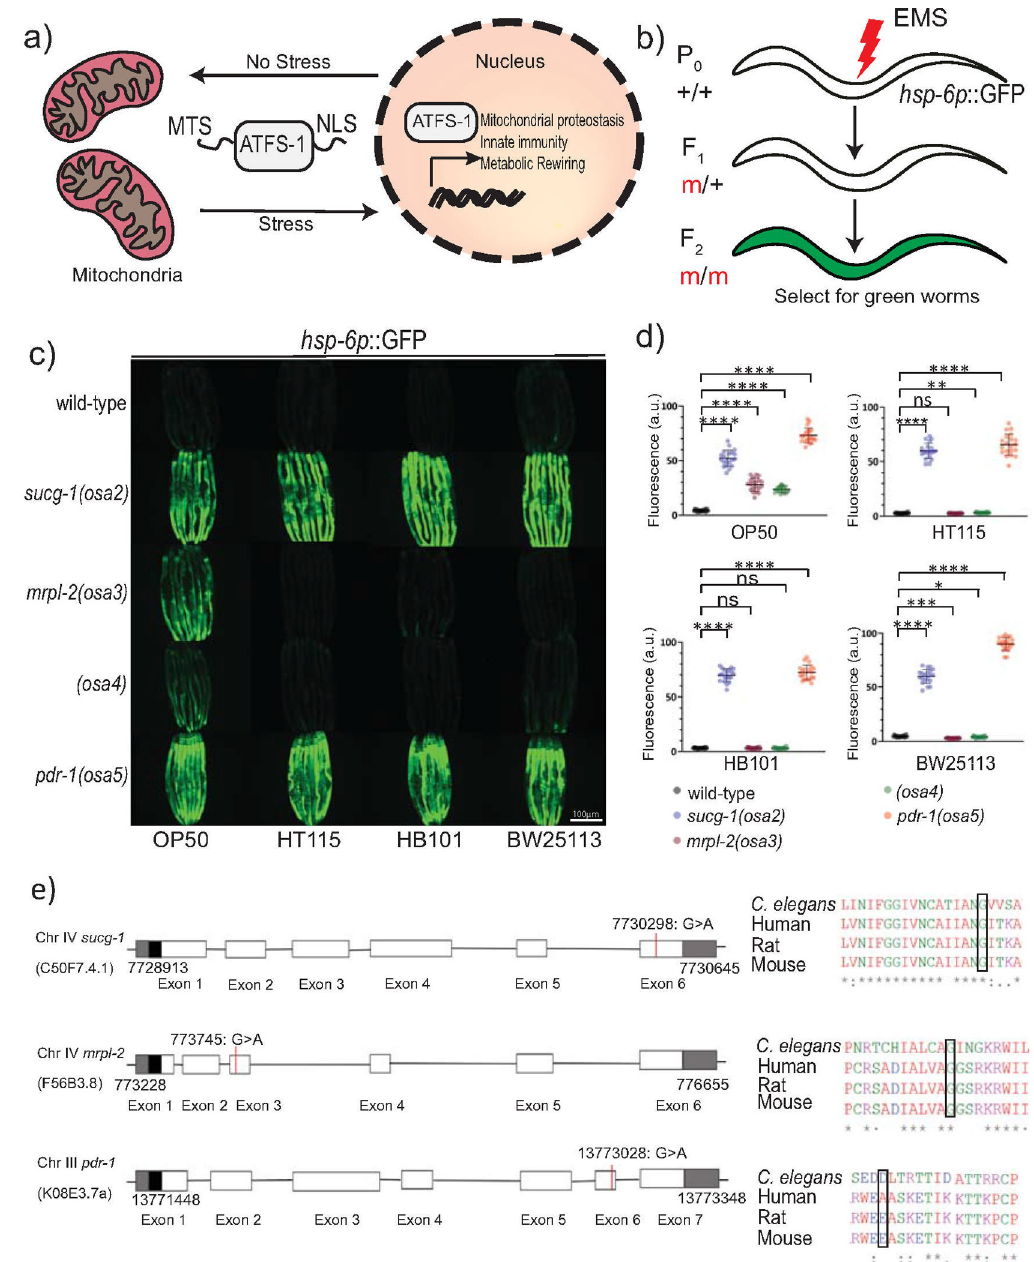
Fig 1. Isolation of novel alleles that activate the UPR mt in diet-dependent and–independent manners. (A) Schematic of the UPR mt response. (B) Schematic illustrating the strategy used to isolate mutants that activate the UPR mt using forward genetics. (C, D) Photomicrographs and quantification of hsp-6p ::GFP expression for the four isolated mutants fed different diets of E . coli . The alleles were named osa2 , osa3 , osa4 and osa5 . Quantification of fluorescence intensities expressed as arbitrary units (A. U.); (mean ± SD; n � 20 worms); ns denotes not significant, � denotes p < 0.05, �� denotes p � 0.01, ��� denotes p � 0.001, ���� denotes p � 0.0001 (Student’s t test). (E) Schematics of gene structure and protein alignment of sucg-1(osa2) , mrpl-2(osa3) , and pdr-1(osa5) with the indicated mutations and amino acid